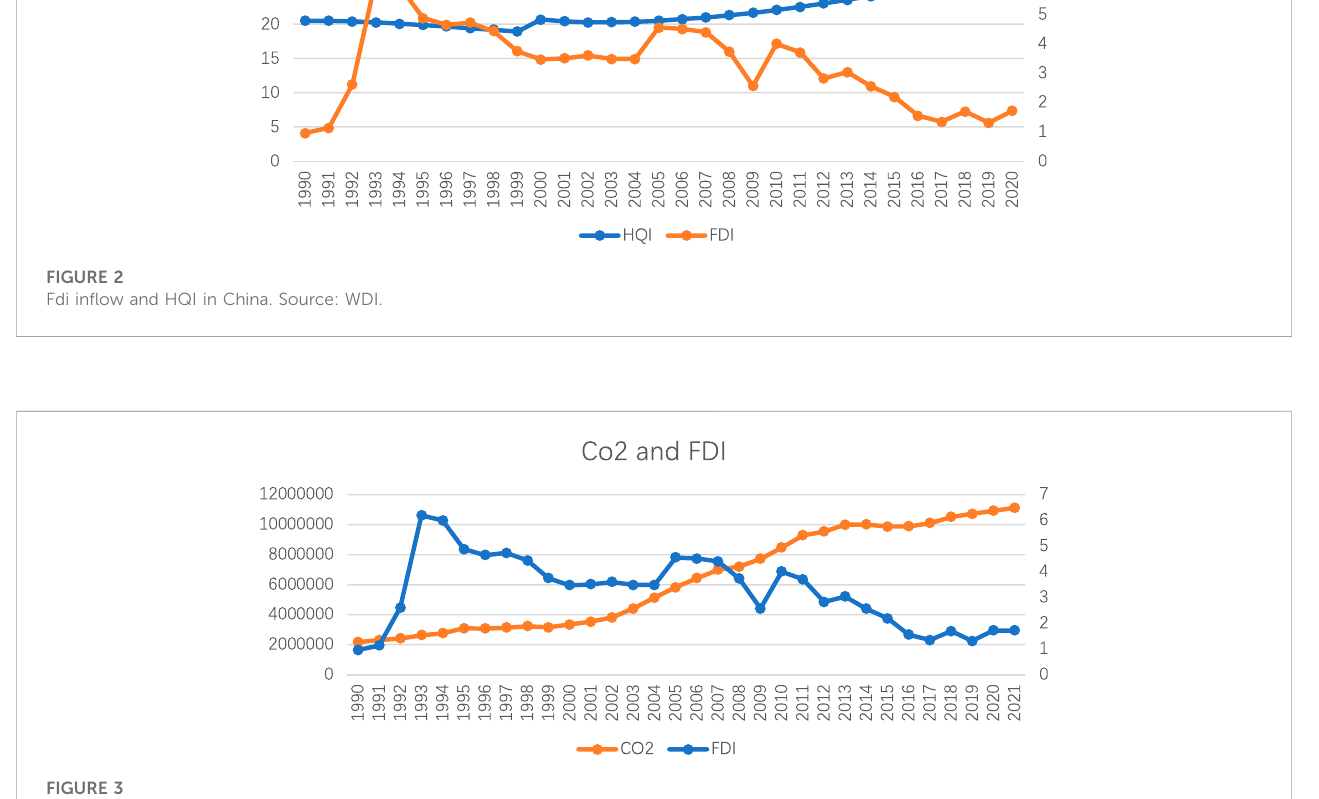
FIGURE 3 CO 2 emissions and FDI in China. Source: